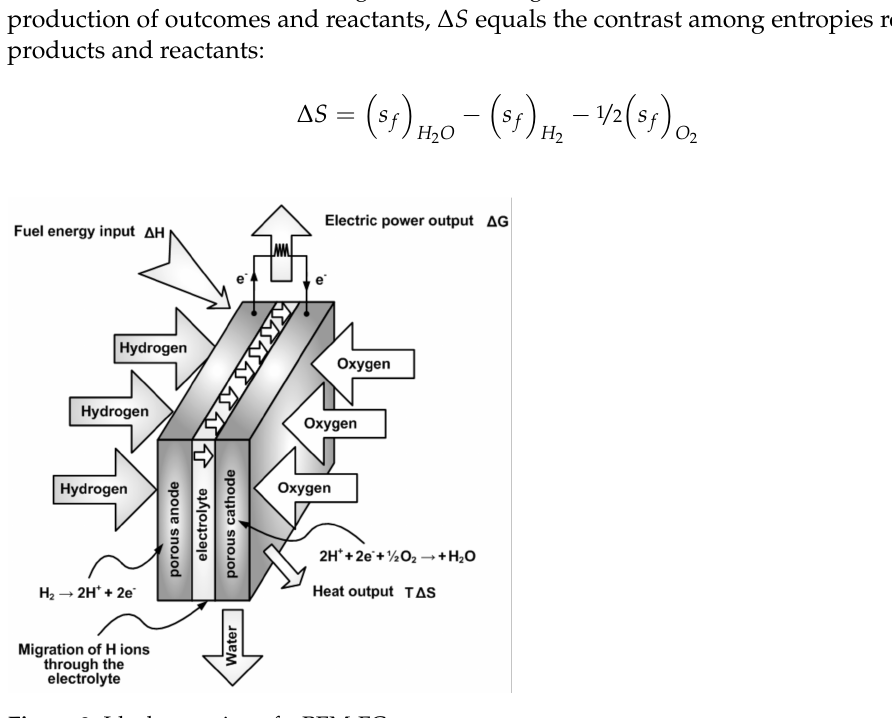
Figure 3. Ideal operation of a